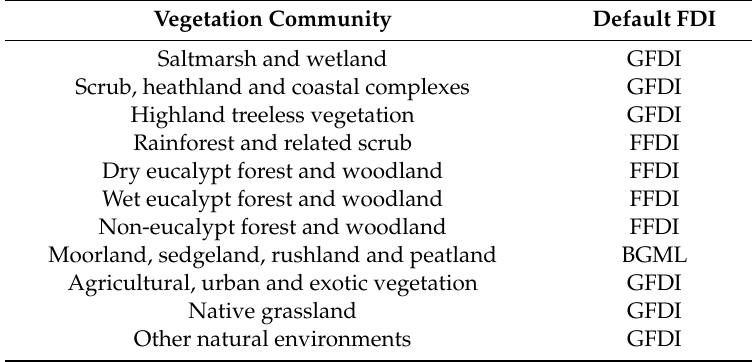
Table 2. Default FDI in Vegetation Community. GFDI, Grassland Fire Danger Index; Forest Fire Danger Index; Button Grass Moorland Fire Index.